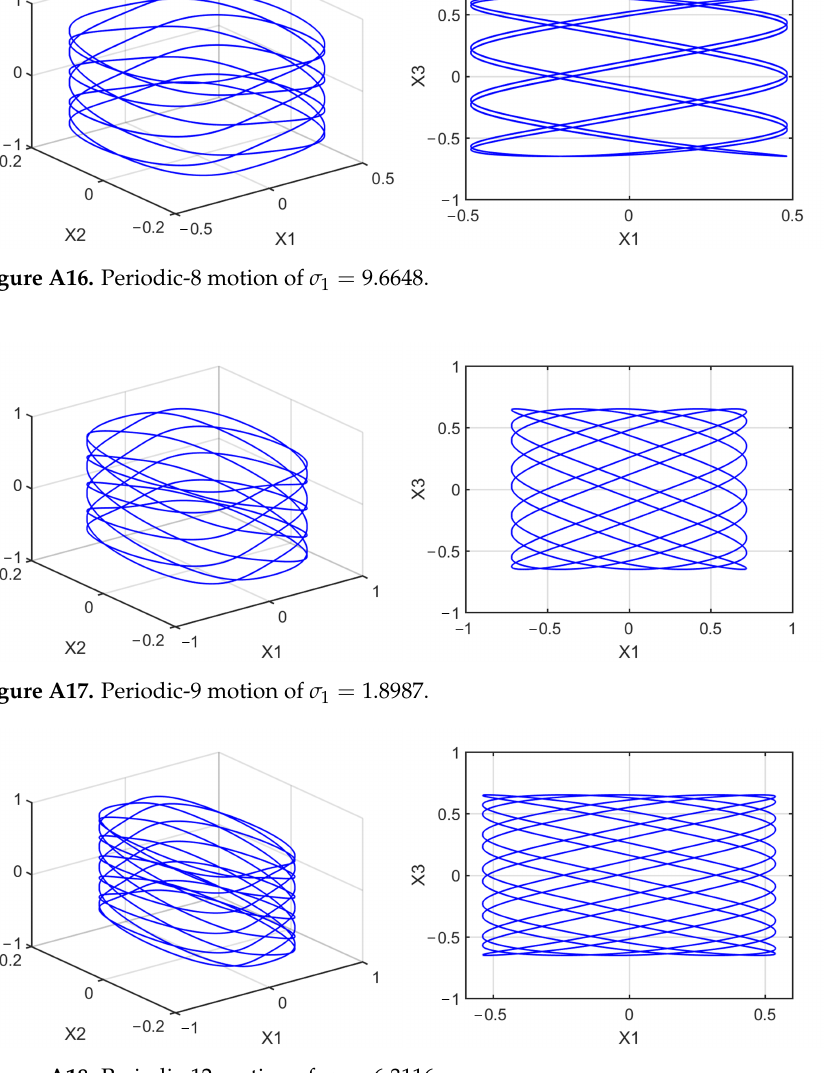
Figure A18. Periodic-12 motion of σ 1 =